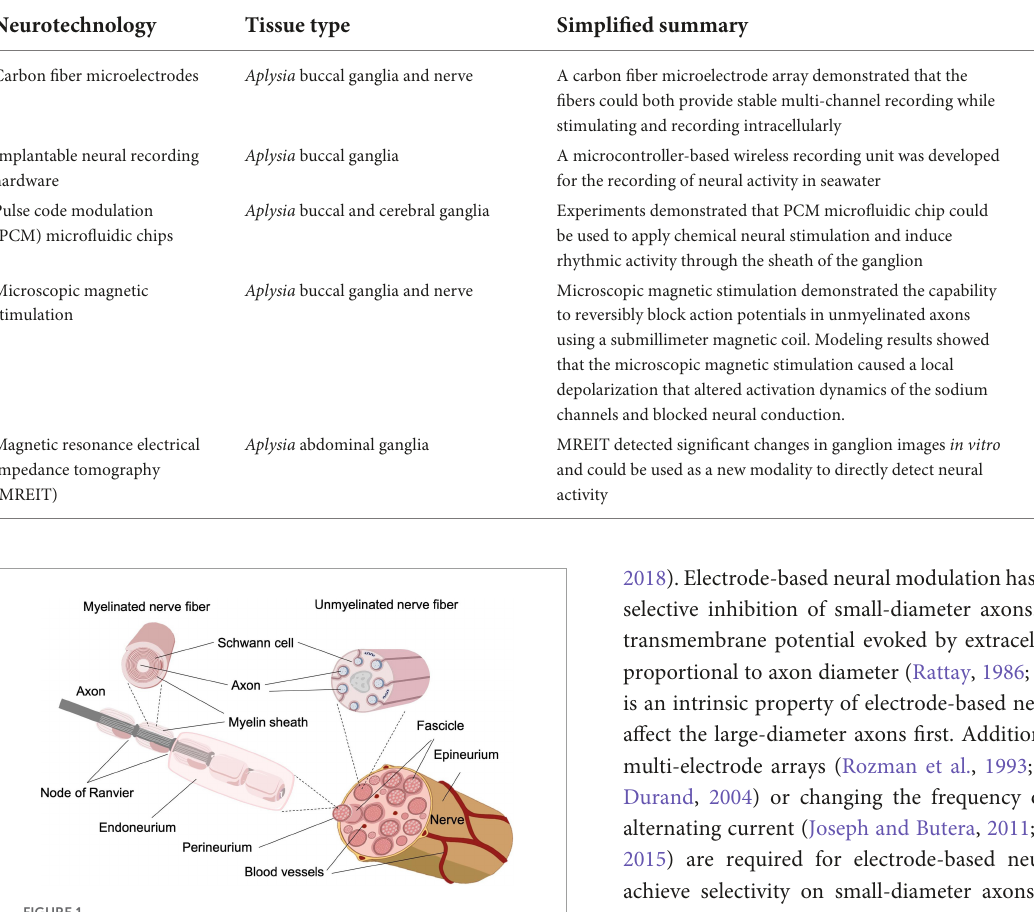
FIGURE1 Schematic of the structure of a peripheral nerve (Guedan-Duran et al., 2020. The original work is published with permission under a Creative Commons Attribution 4.0 International License. To view a copy of this license, visit http://creativecommons.org